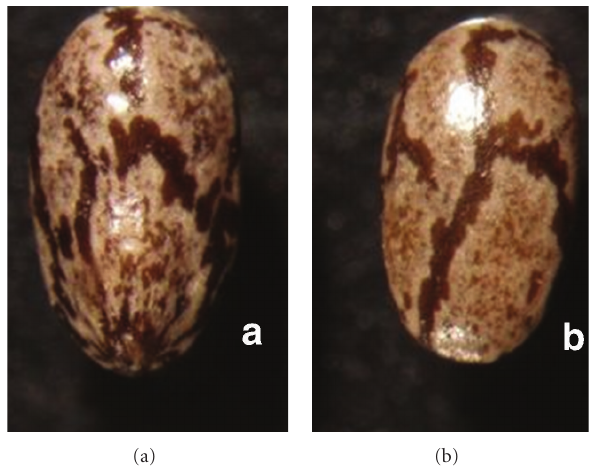
Figure 2: Salvia hispanica L. seeds with brown stripes color [10]. They can also be found having white and dark seed coat colors [8].